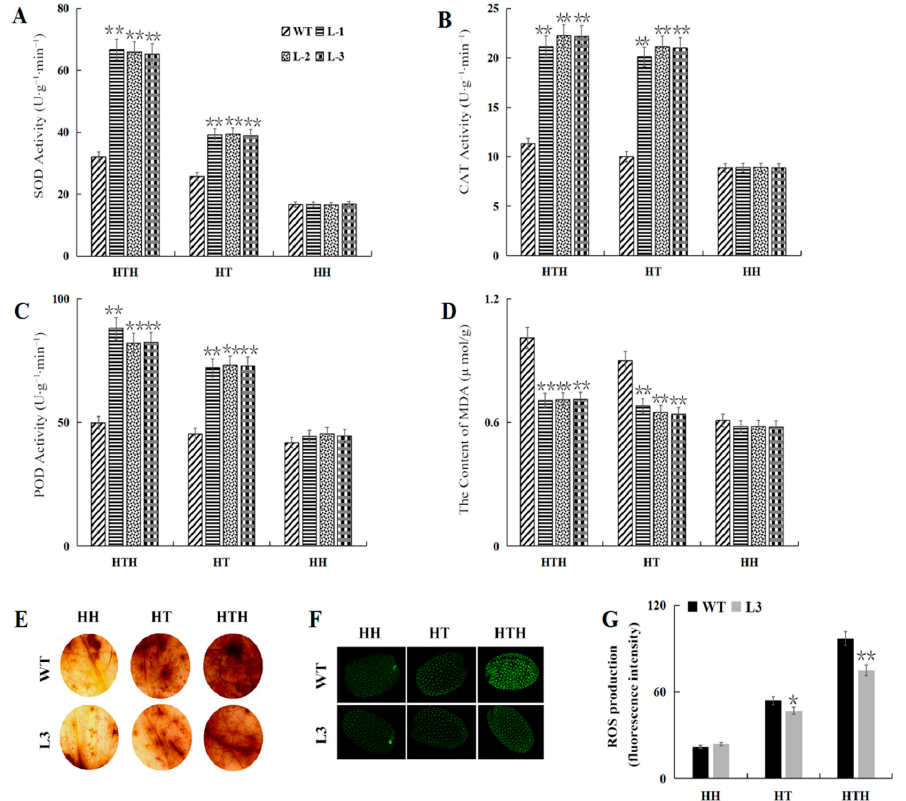
Figure 5. Effects of HT, HH, and HTH stresses on antioxidase activity and ROS scavenging ability of the WT and GmATX1 -overexpressed Arabidopsis lines. ( A – D ) Activities of SOD, CAT, and POD and the content of MDA in the leaves of the 4-week-old seedlings of the WT and transgenic Arabidopsis lines (L1, L2, and L3) after the HT, HH, and HTH treatments, respectively, for 2 d. ( E ) Staining of H 2 O 2 in the leaves of the 4-week-old seedlings of the WT and transgenic Arabidopsis lines (L3) after the HT, HH, and HTH treatments, respectively, for 2 d. ( F , G ) ROS levels in the seeds harvested from the WT and transgenic Arabidopsis (L3) after the HT, HH, and HTH treatments, respectively, for 2 d. The values shown are mean ± SD from three biological replicates. * and ** indicate significant